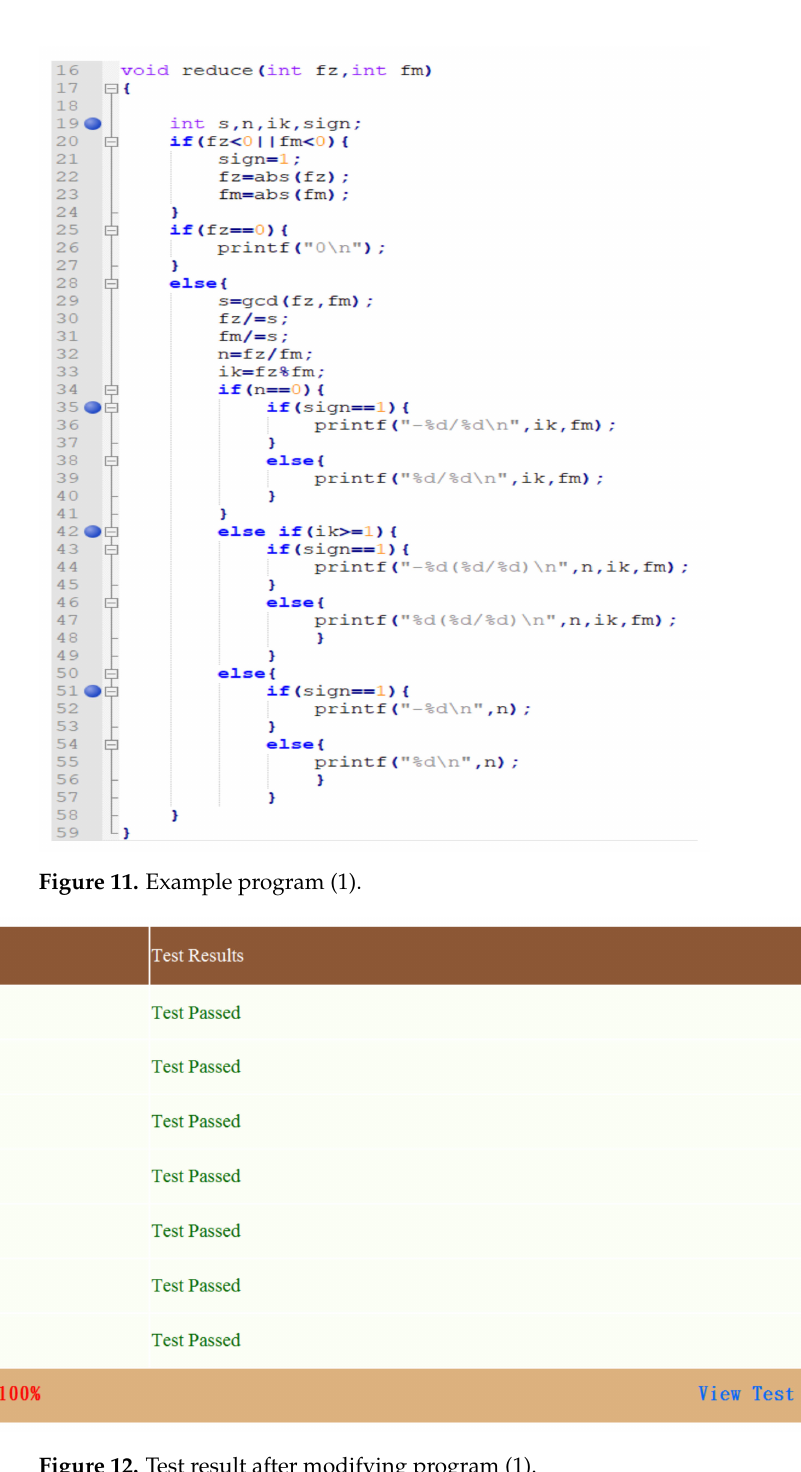
Figure 12. Test result after modifying program (1).